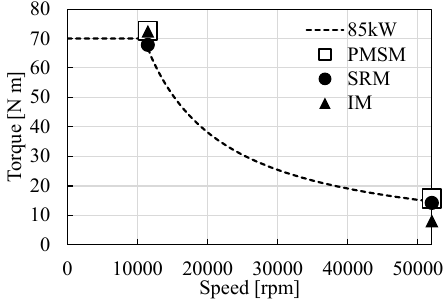
Figure 21. Output power characteristics.